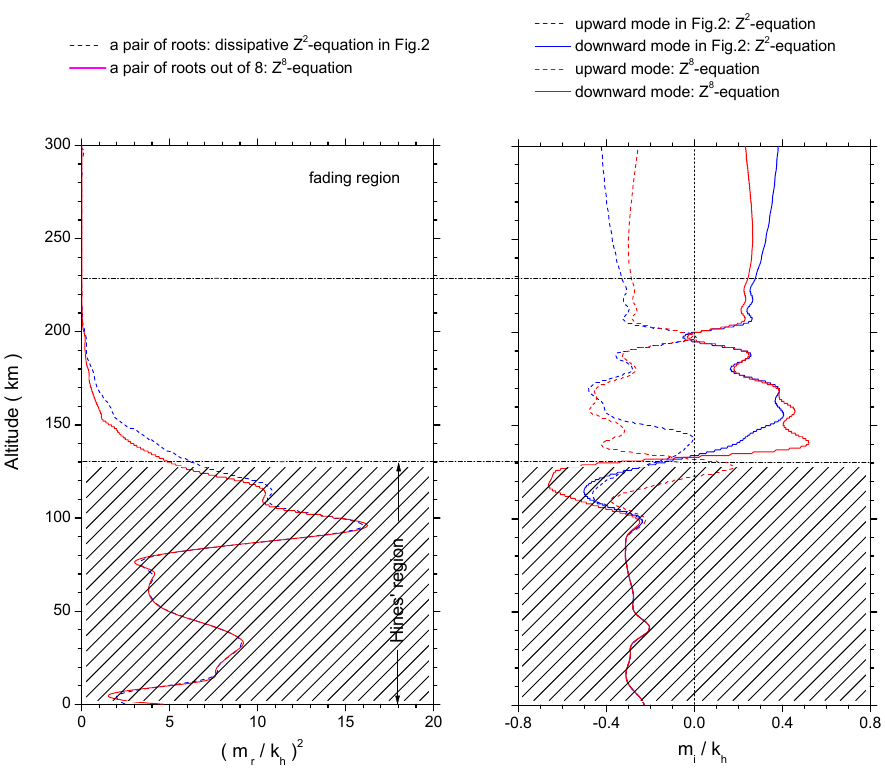
Figure 5. Comparison between the two ordinary viscosity wave modes from the solutions of the Z 2 -dispersion equation, Equation (16), and the two ordinary dissipation (viscosity + conduction) wave modes out of the eight complex solutions of the Z 8 -dispersion equation, Equation